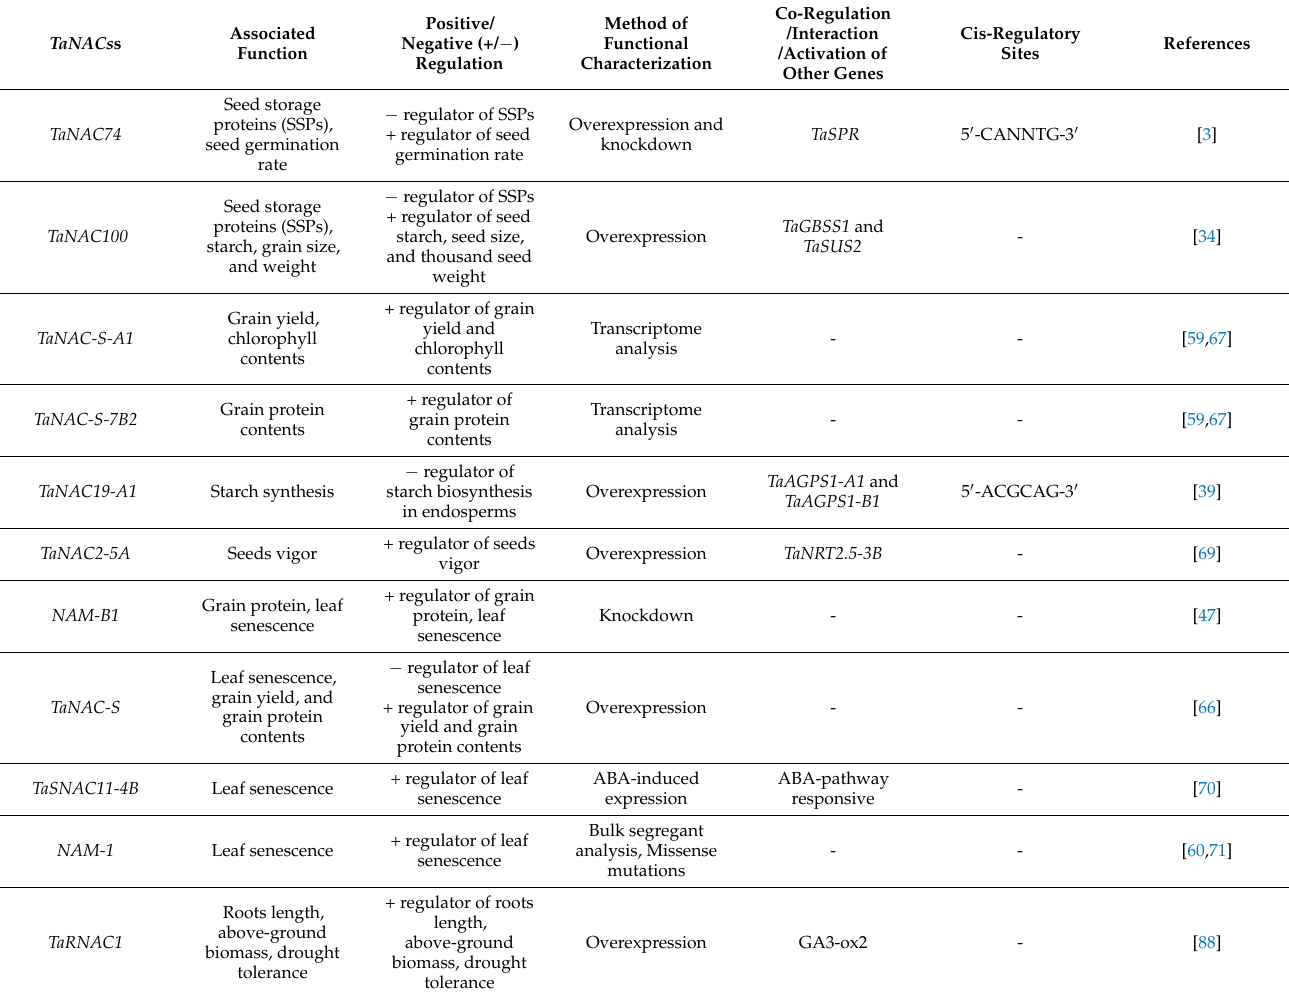
Table 1. Summary of wheat TaNAC genes and their associated